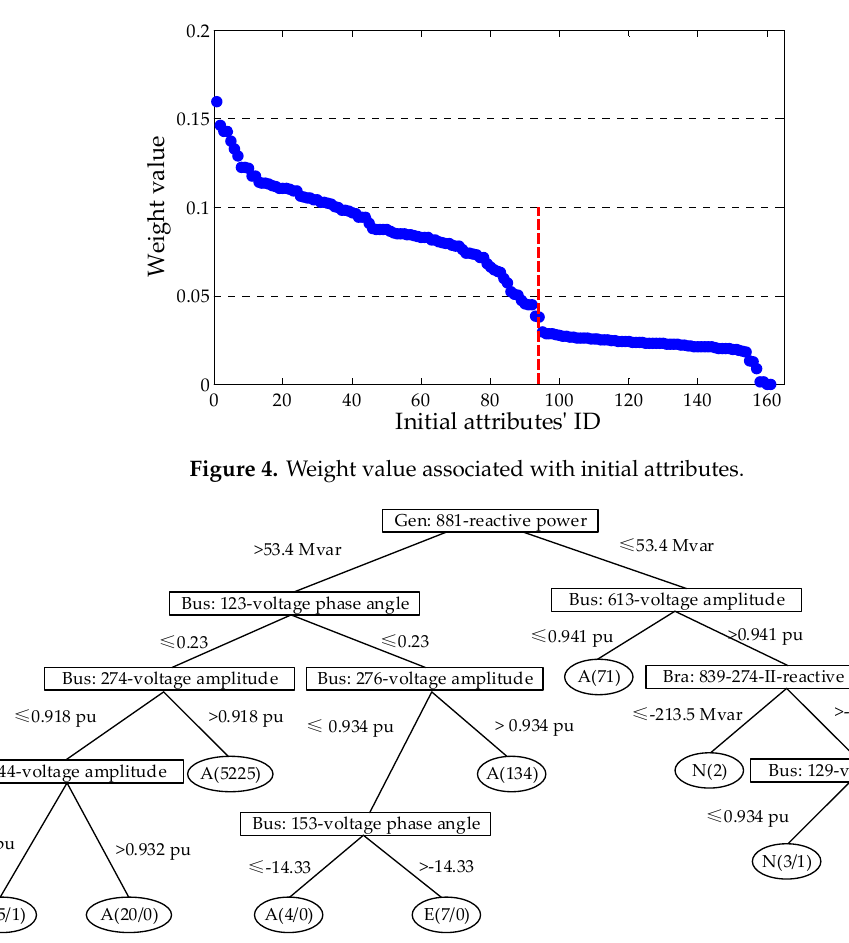
Figure 5. Partial decision tree (DT).